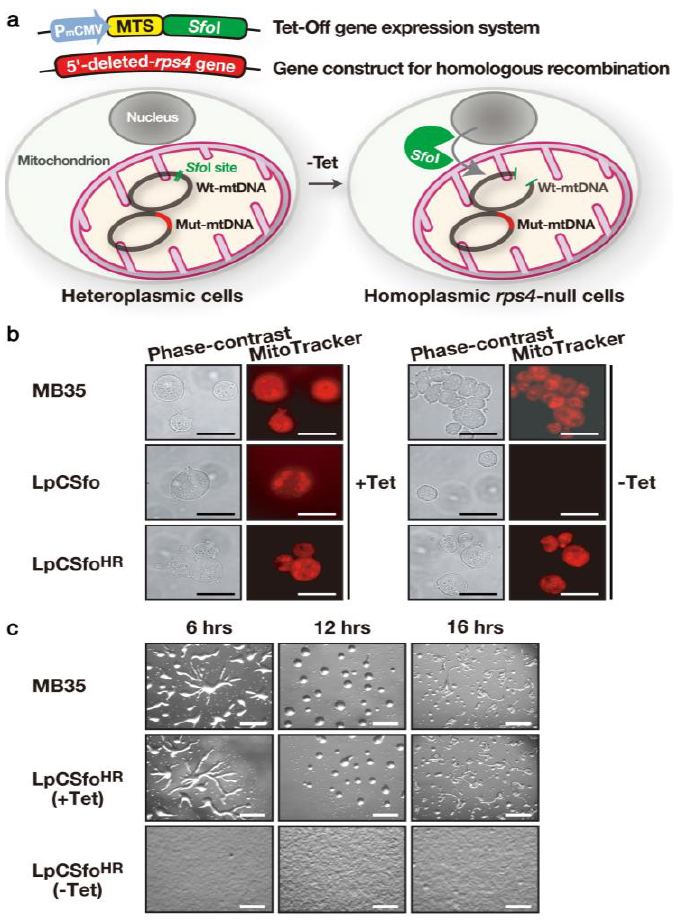
Figure 3. Strategy for creating rps4 -null cells and their phenotypes. ( a ) As a starting material, LpCSfo cells in which pCoxIV (MTS)- Sfo I is expressed under the tetracycline-minus (−Tet) condition, were prepared. Subsequently, the mutant rps4 gene (Mut-mtDNA for homologous recombination), in which the upstream Sfo I-site and a 5'-half of rps4 coding region were deleted, was introduced into LpCSfo cells to obtain heteroplasmic transformants (LpCSfo HR cells) with mitochondria consisting of the Mut-mtDNA and wild-type mtDNA (Wt-mtDNA). Coupled with removal of Tet from growth medium, the fusion protein MTS- Sfo I synthesized in the cytoplasm is exclusively transferred into mitochondria of LpCSfo HR cells and selectively digests Wt-mtDNA but not Mut-mtDNA. Since the digested Wt-mtDNA is not duplicated, the Mut-mtDNA becomes dominant during the course of growth under the −Tet condition, thus eventually giving rps4 -null cells. ( b ) These cells were grown in growth medium with (+Tet) or without (−Tet) teteracyclin. Membrane potential of mitochondria was visualized by staining of cells with MitoTracker Orange. As was expected, the staining of mitochondria was almost completely vanished in LpCSfo cells grown without Tet, because their mtDNA with an intact Sfo I site would be cleaved by Sfo I eventually to become a ρ 0 state devoid of mitochondrial DNA. Bars, 200 nm. ( c ) Development of starved MB35 cells and LpCSfo HR cells on agar. MB35 cells and LpCSfo HR cells grown with (+Tet) or without (−Tet) tetracycline were washed twice in BSS and plated on 1.5% non-nutrient agar at a density of 5 × 10 6 cells/cm 2 . This was followed by incubation for the indicated time at 22 °C. Bars, 0.5 mm. (Basically from Chida et al .